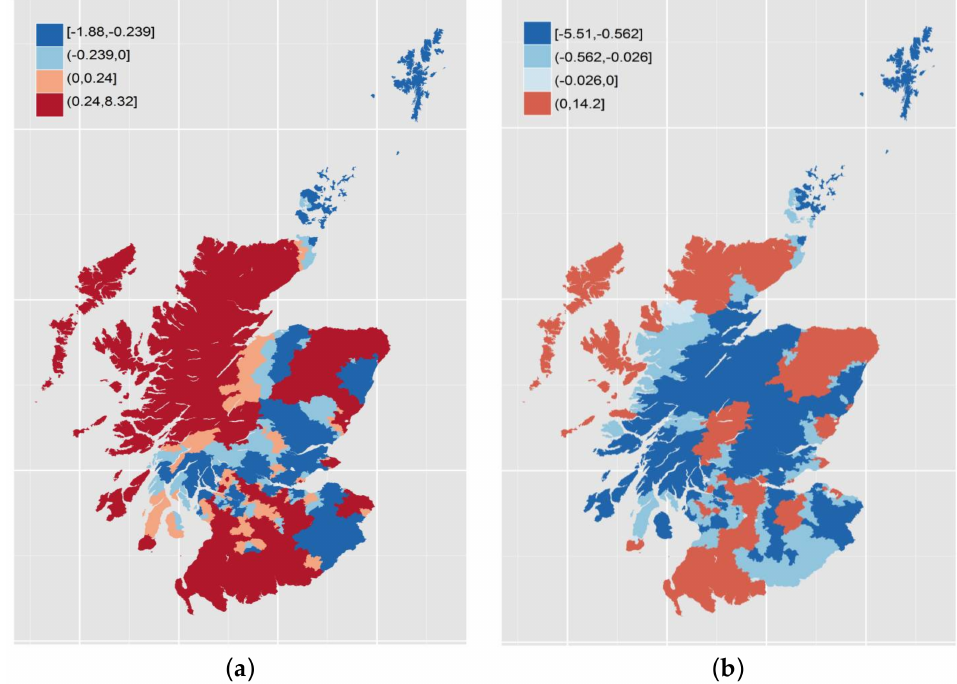
Figure 4. Local coefficients for squared income deprivation: 2004 ( a ); and 2012 ( b ).